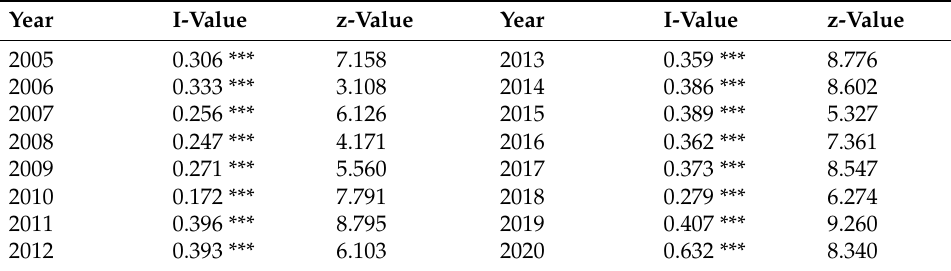
Table 1. Moran’s I calculation results for county